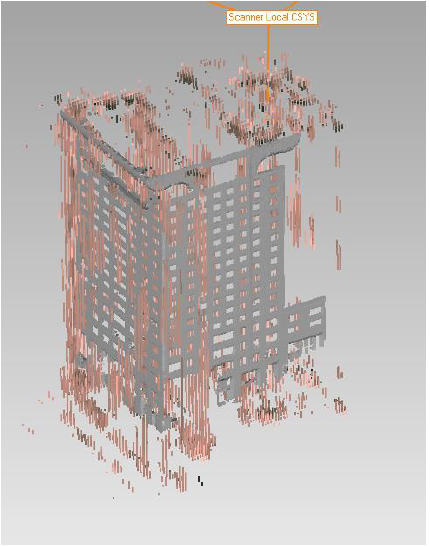
Fig4-1. Point Cloud Obtained From Terrestrial Lidar